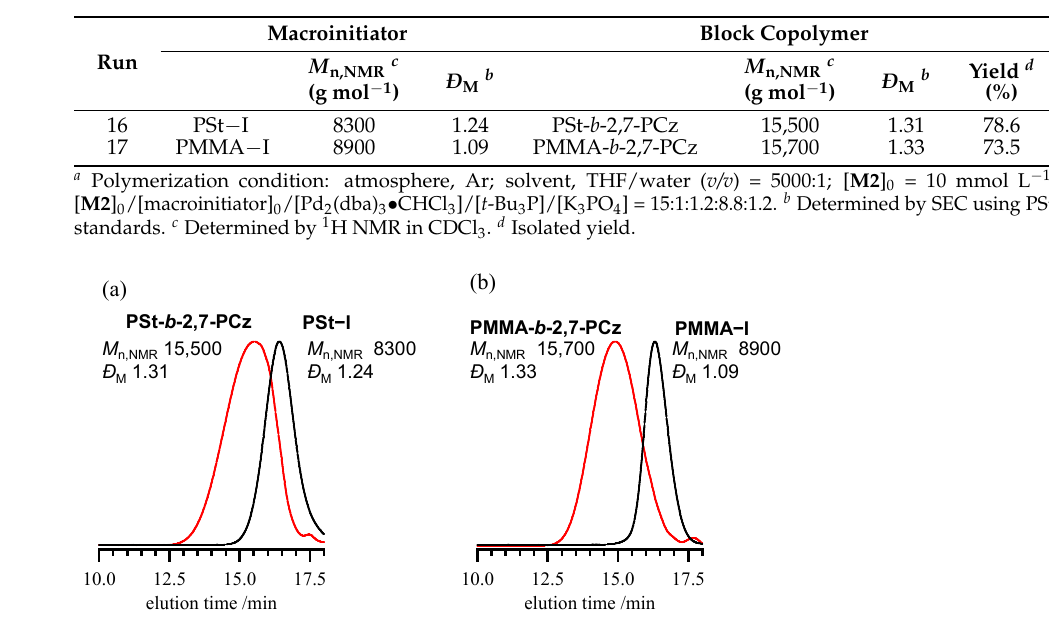
Table 3. Polymerization of M2 using macroinitiators. a.